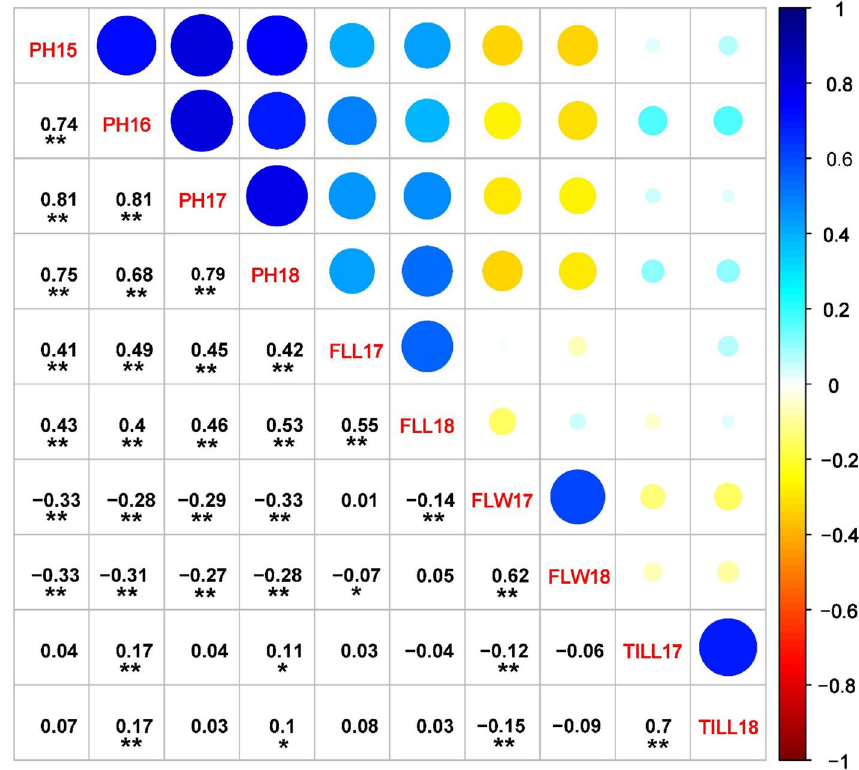
Figure 2. Correlation among plant architectural traits across multiple environments. PH-Plant height (2015– 2018), FLL-Flag leaf length (2017–2018), FLW-Flag leaf width (2017–2018) and TILL-Number of tillers per plant (2017–2018). * and ** indicate significant correlation at P < 0.05 and 0.01,